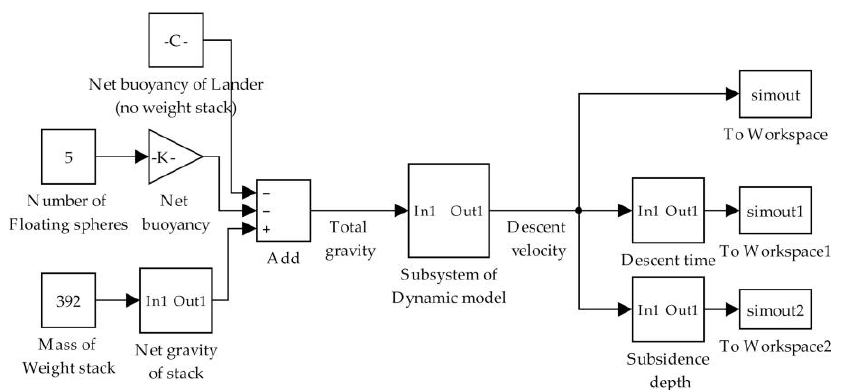
Figure 4. Simulink block diagram model.